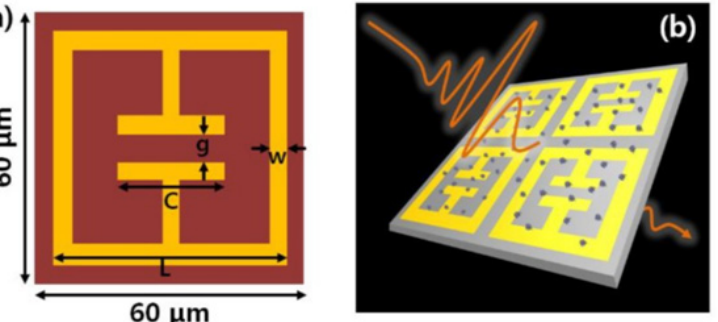
Figure 17. PMS unit cell ( a ) and schematic of the THz sensing experiment ( b ). Reprinted from [177].